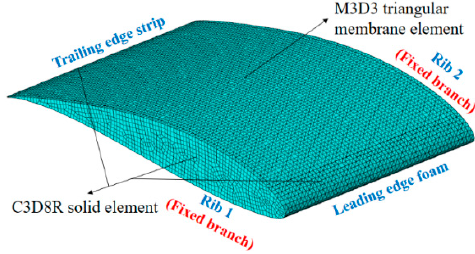
Figure 20. Finite element model of membrane wing.